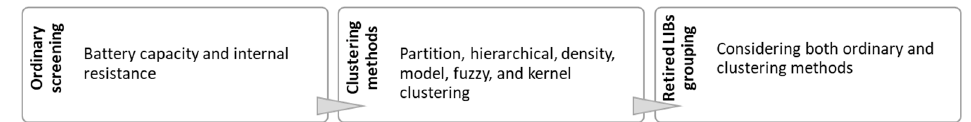
Figure 15. Overview of EV battery clustering based on capacity and internal resistance proposed in [67].